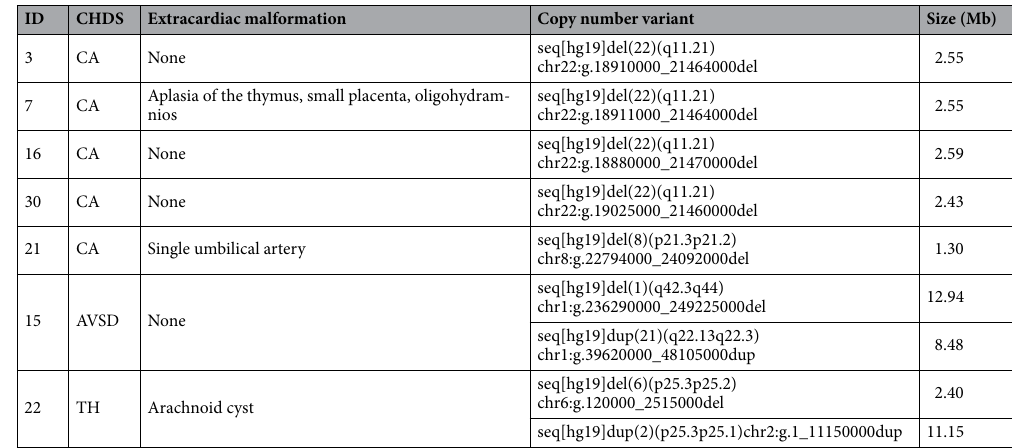
Table 3. Pathogenic copy number variants in the cohort. AVSD atrioventricular septal defect, CA conotruncal anomalies, CHDS congenital heart defect subtype, TH Tricuspid hypoplasia.